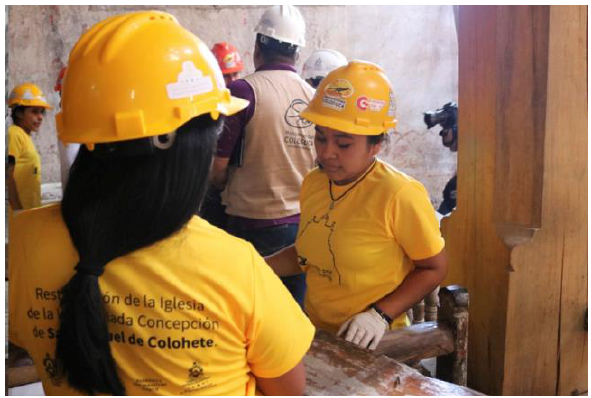
Figure 5. Community volunteers of San Manuel de Colohete working in preventive protection of the polychrome wood in the inside of the church during a guided tour. Source: http://www.aecid.hn/sitio/attachments/article/540/